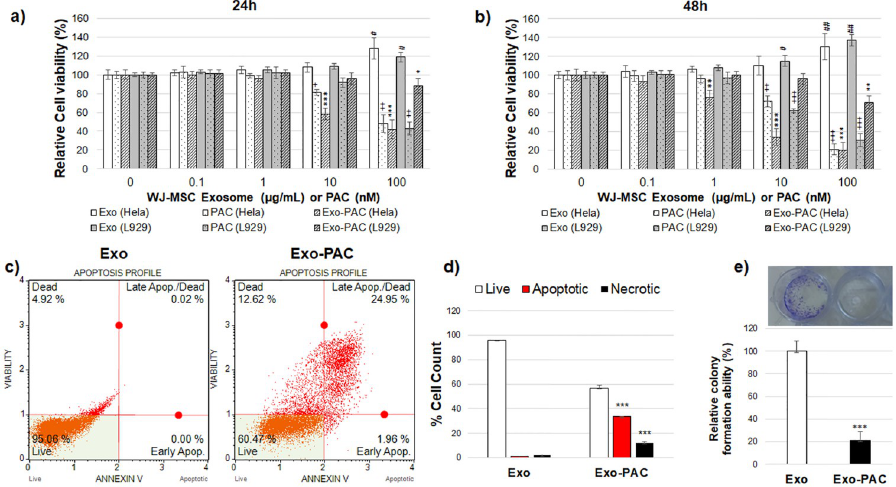
Fig 3. Exo and Exo-PAC application to Hela and L929 cells a) 24 hours and b) 48 hours cell viability graph c) Annexin V binding graphs of Exo-PAC in Hela cells d) Annexin V binding levels in Hela cells e) Colony formation levels in Hela cells ( �� p < 0.01, ��� p < 0.001 compare to